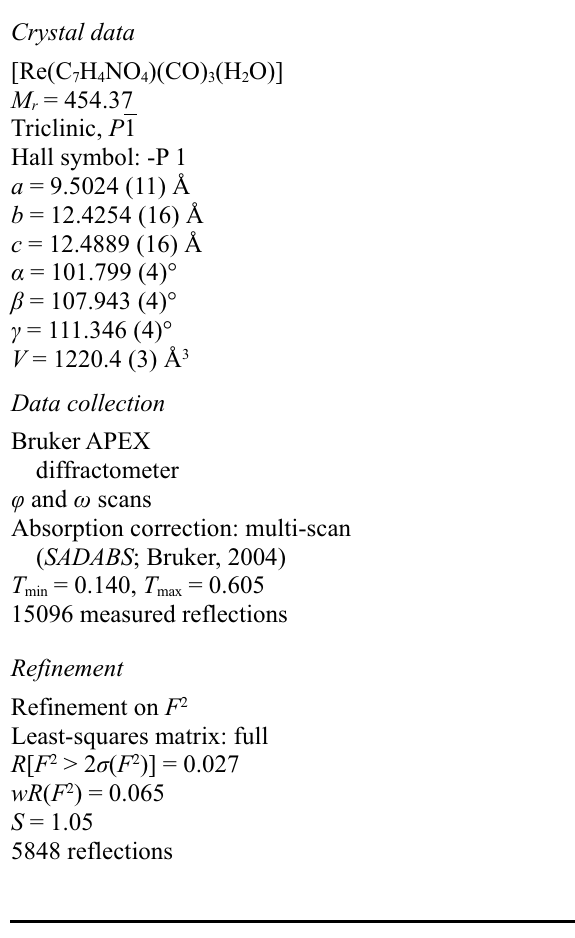
Figure 1 Representation of the title compound, showing the numbering scheme and displacement ellipsoids (50% probability). Aquatricarbonyl(4-carboxypyridine-2-carboxylato- κ 2 N , O 2